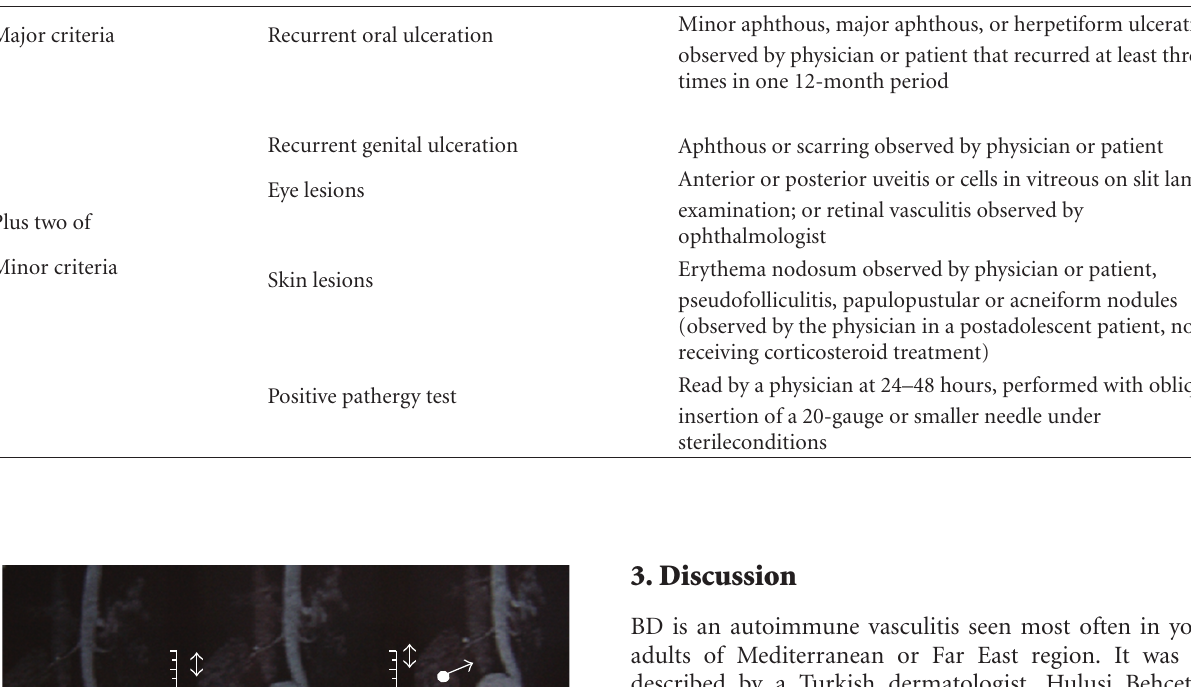
Table 1: International study group criteria for the diagnosis of Behc¸et’s disease.